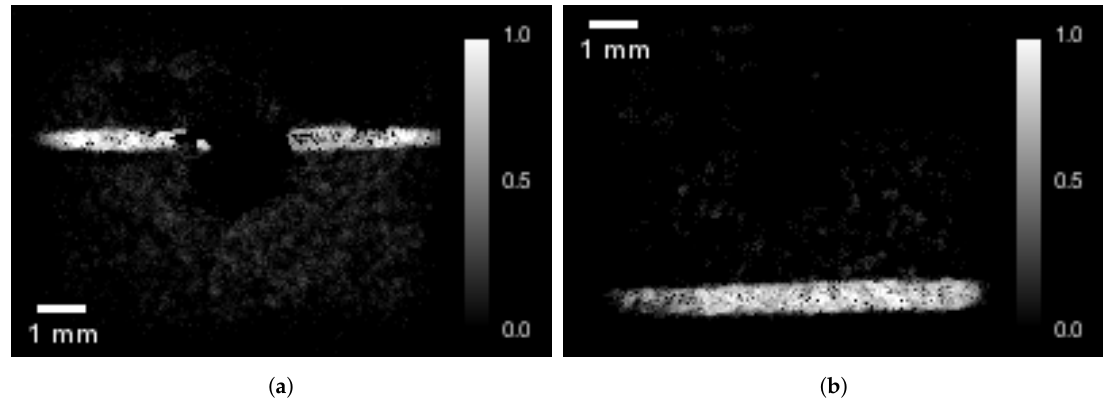
Figure 9. Neutron image of knife edge slit in thin cadmium attenuating sheet. ( a ) slit: 500 µ m; ( b ) slit: 750 µ